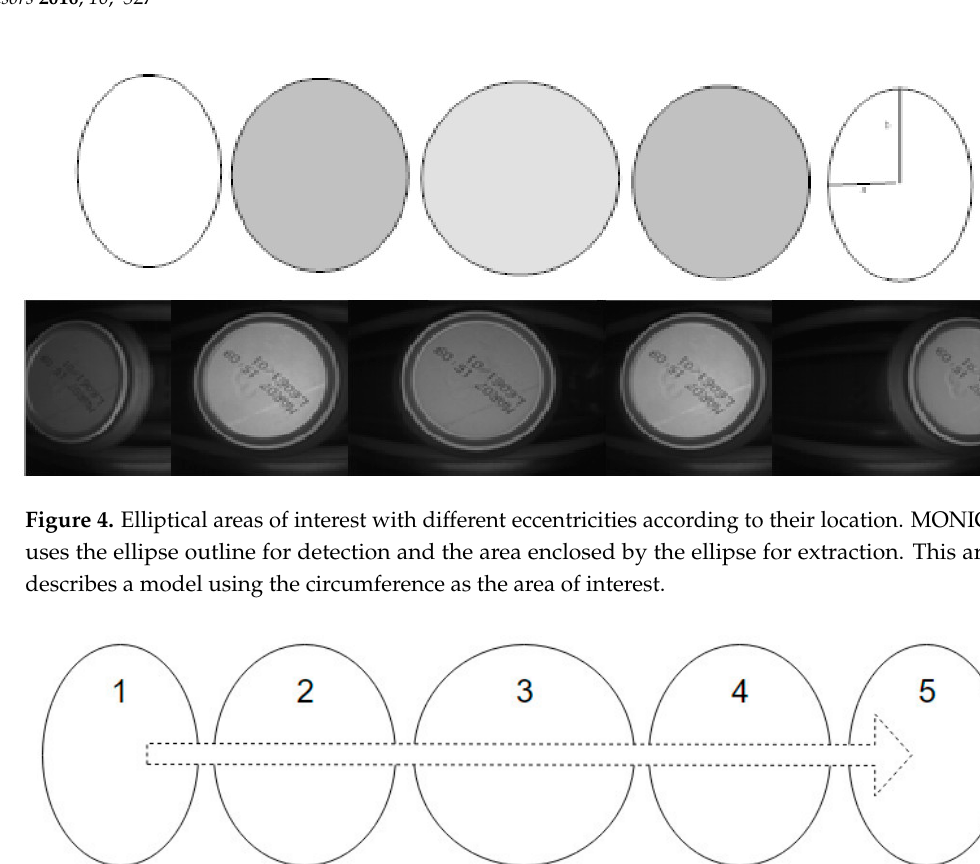
Figure 4. Elliptical areas of interest with different eccentricities according to their location.